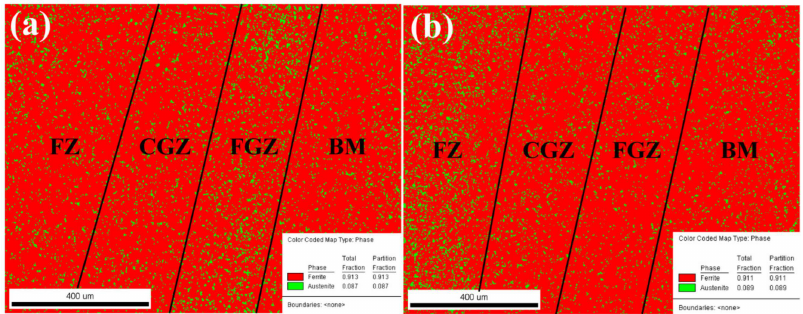
Figure 21. Distribution of retained austenite: ( a ) before quenching; ( b ) after